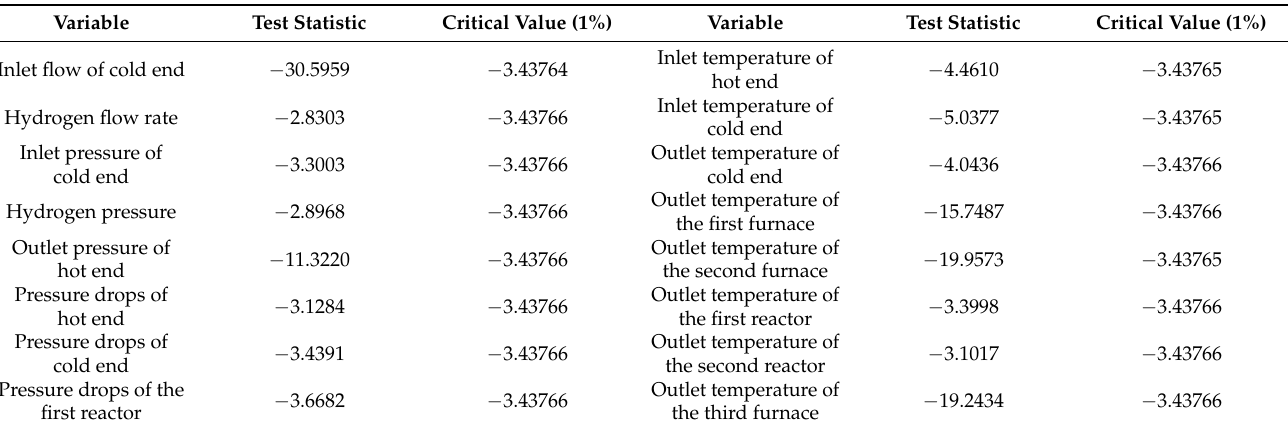
Table 4. Unit root test results of training